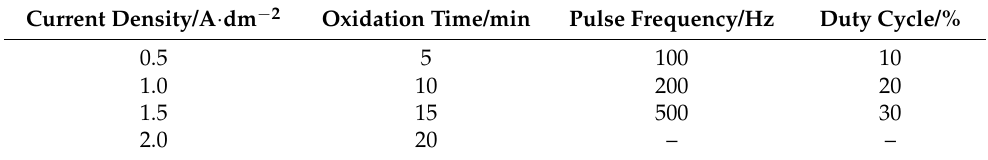
Table 2. Electrical parameters and its